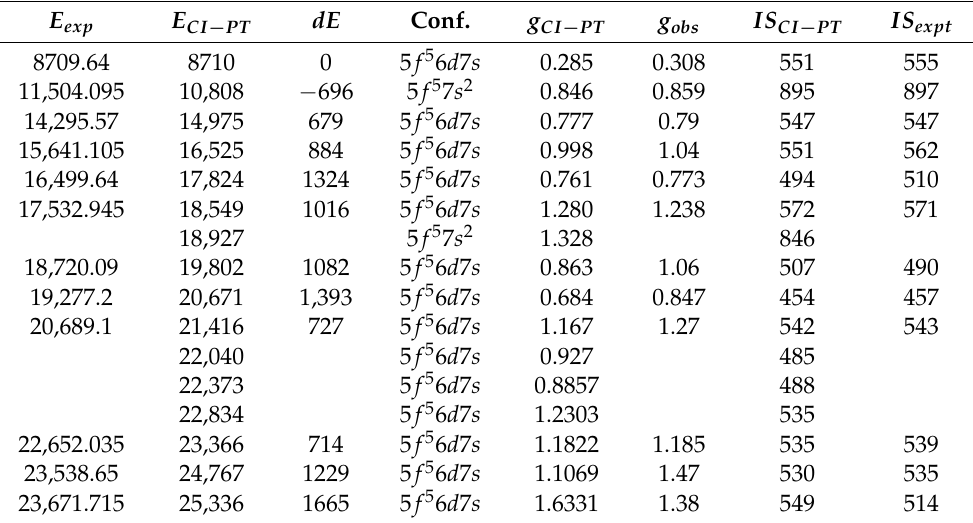
Table 3. Pu II Energy levels (cm − 1 ), g-factors, and ISs (mK or 10 − 3 cm − 1 ) of J = 3.5 odd states, which for pure configurations are assumed to be 941 for 5 f 5 7 s 2 , 555 for 5 f 5 6 d 7 s , and 294 for 6 d 2 from fitting IS of the nine lowest experimental states. The number of theoretical levels exceeds the number of identified experimental levels. E exp E CI − PT dE